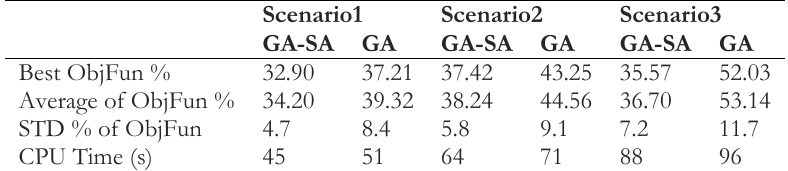
Table 13. Comparison of the different algorithms over 10 runs for the different